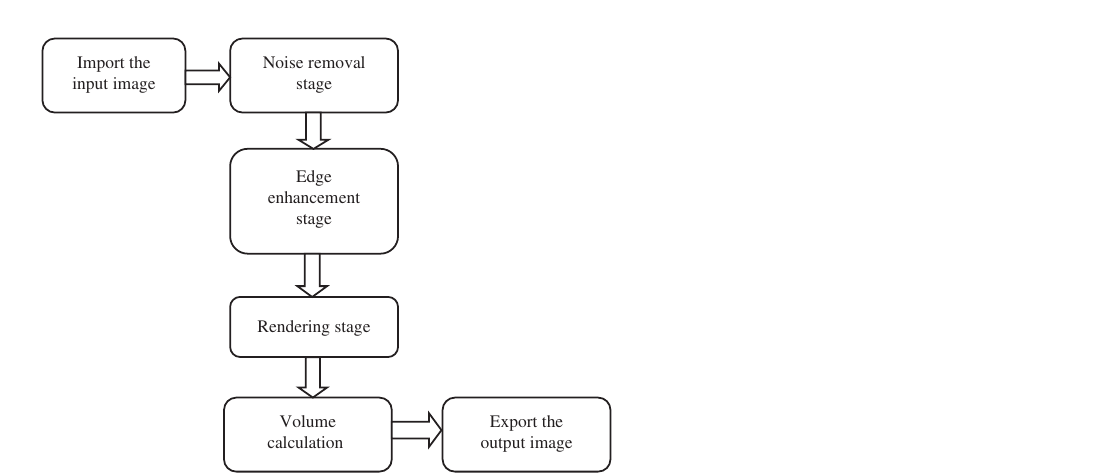
Figure 3: Flow Diagram for the Proposed Image Visualization Pipeline